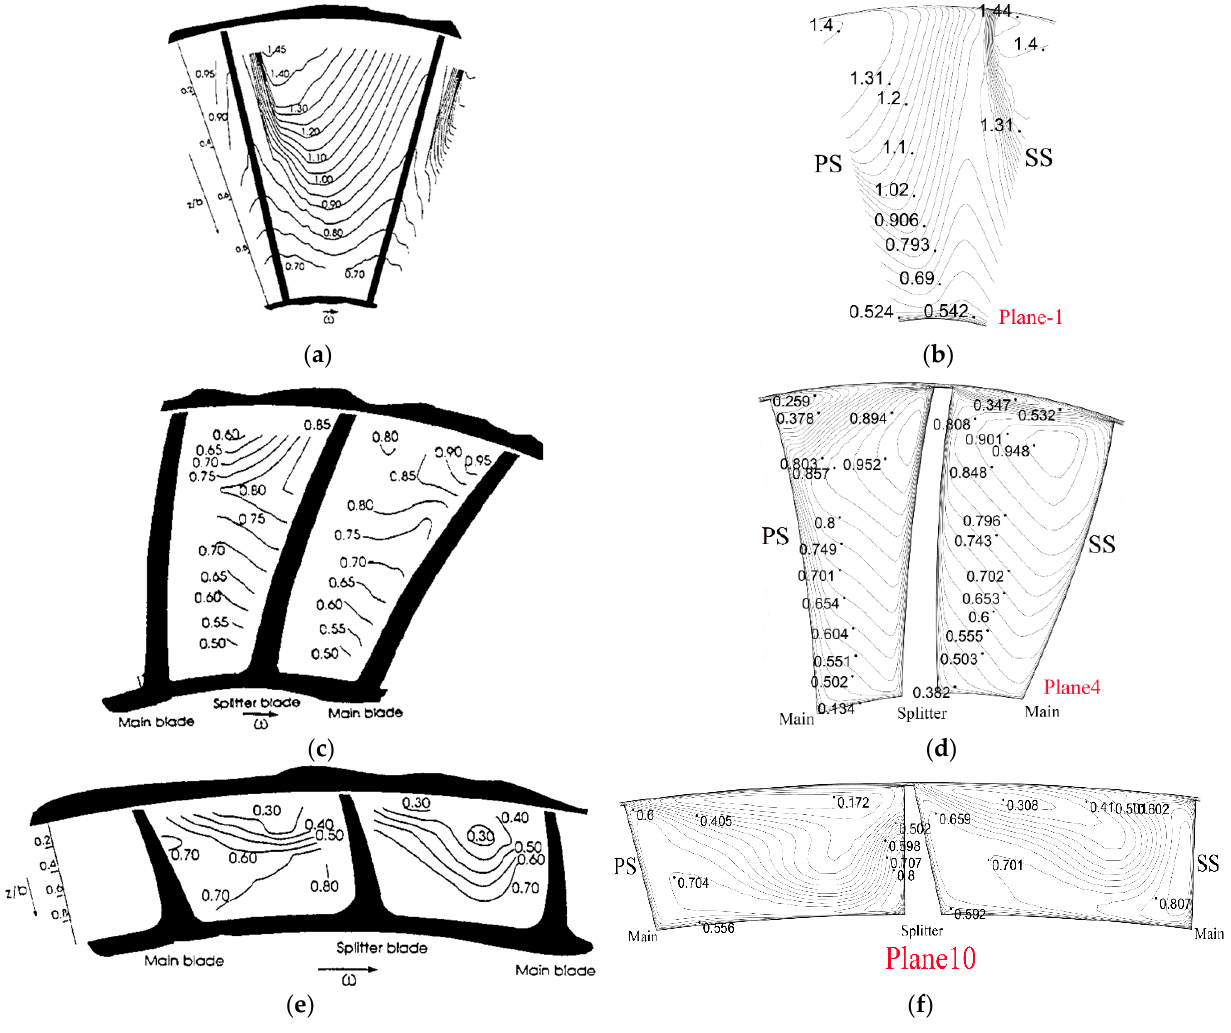
Figure 8. The experimental laser measurement planes in the compressor passage.